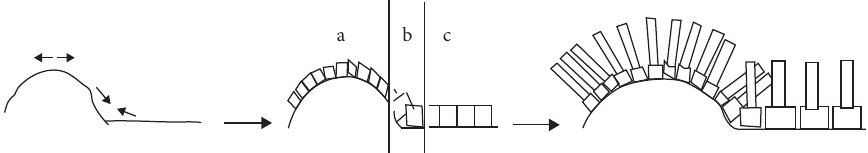
Figure 5: Effect of the bending stresses on the NWs density. Arrows indicate the corresponding stresses. In-plan tensile stresses on the top surface of the bent region (region a) result in the growth of dense NWs. On the contrary, the unbent region (region c) is covered by less dense NWs because of the grain size.